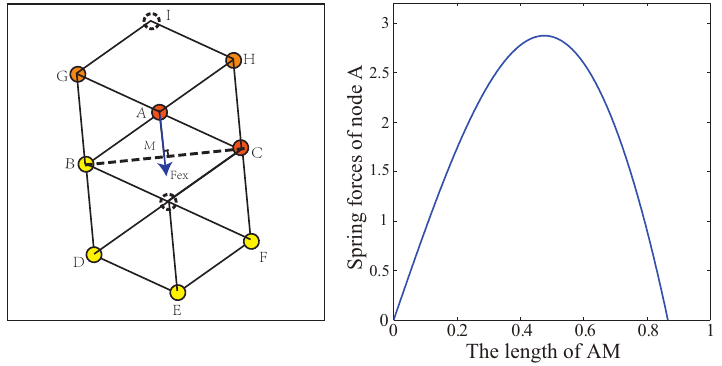
Figure 6. Spring force of sensor node A affected by the length of